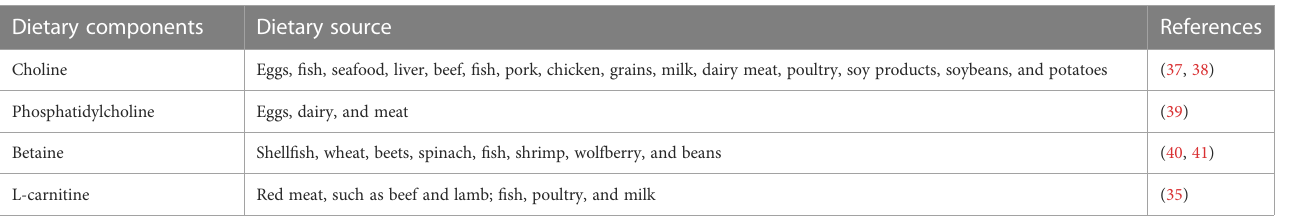
TABLE 1 The dietary precursors of